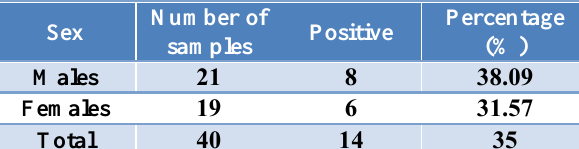
Table, 2: Prevalence of Eimeria spp infection according to sex.